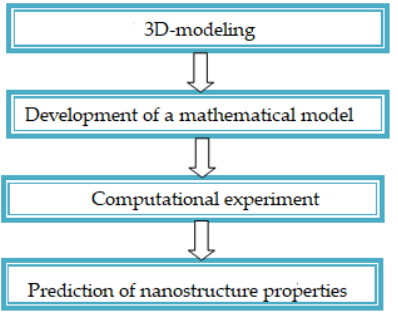
Figure 1. Enlarged diagram of the modeling process .